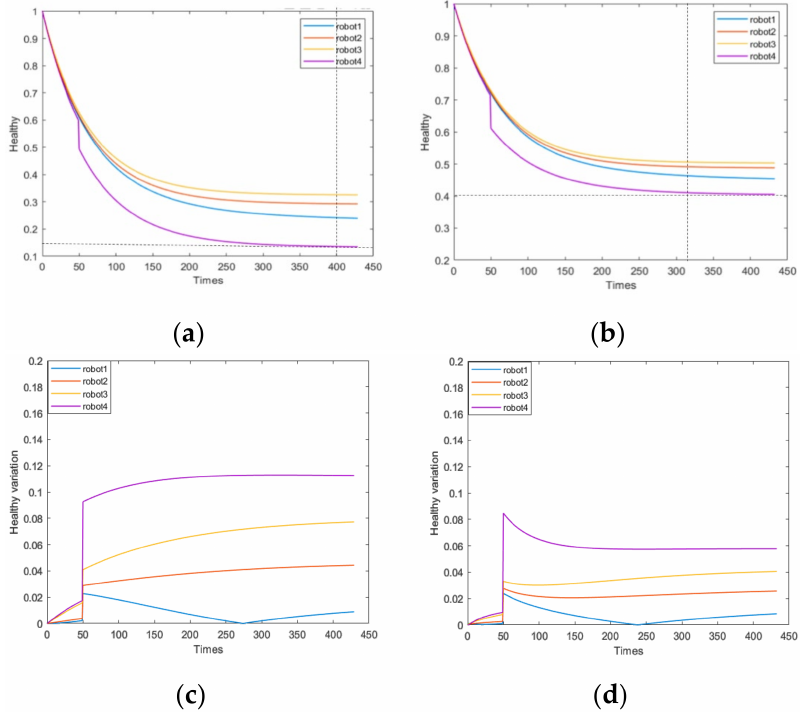
Figure 13. Comparison before and after adding HOM in the third scenario: ( a ) h i ( t ) of robots under normal conditions; ( b ) h i ( t ) of robots under HOM; ( c ) e i ( t ) under normal situations; ( d ) e i ( t ) under